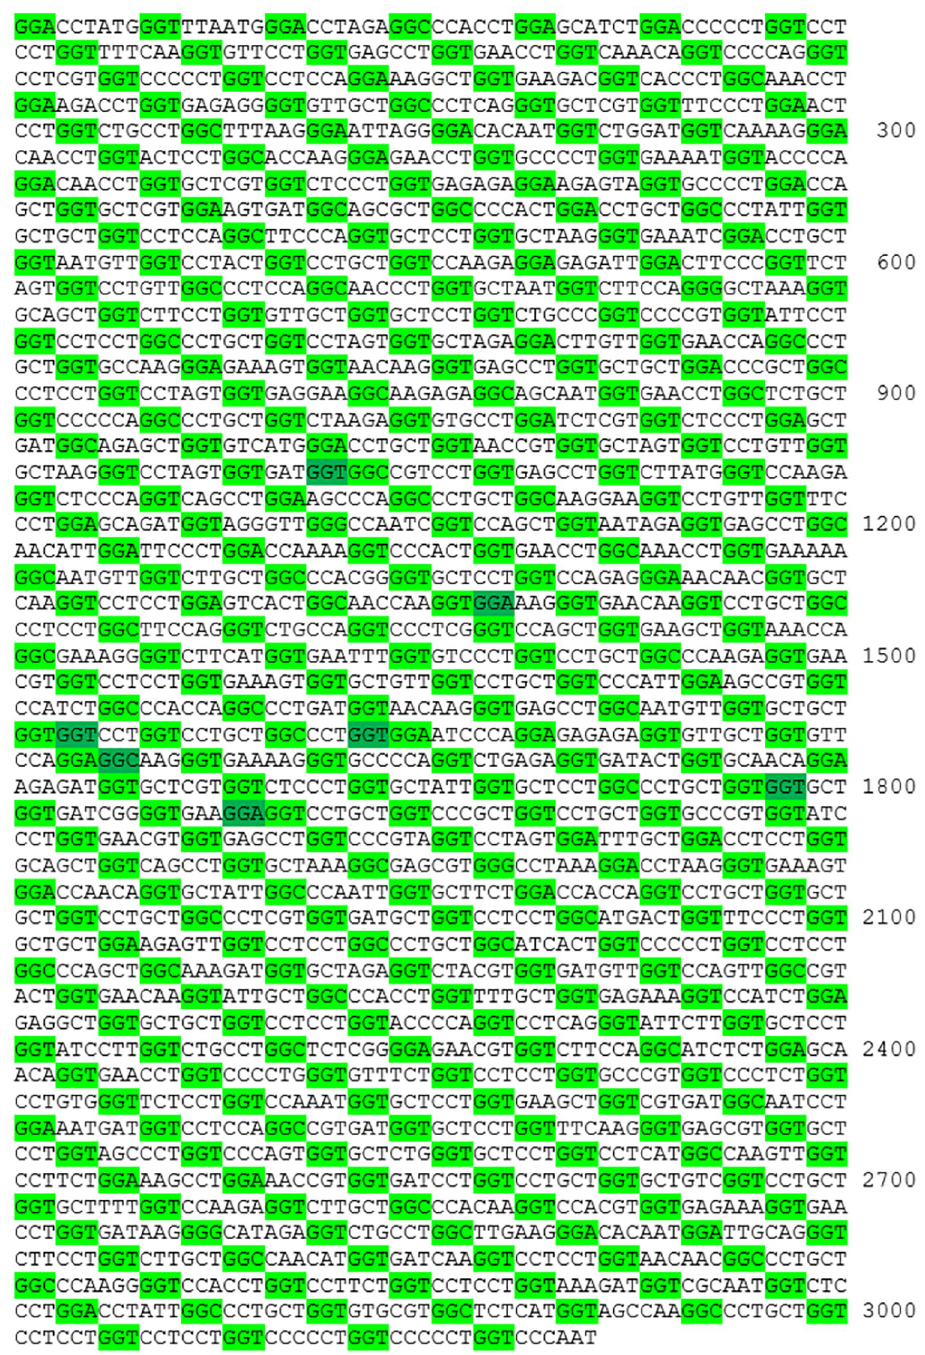
Fig 1. Constructed coding DNA sequence of the common bird ancestor. Constructed coding DNA sequence of the avian common ancestral collagen 1 α 2 GXY domain. Glycine codons in the 1 st GXY position are highlighted in light green and other glycine codons in dark